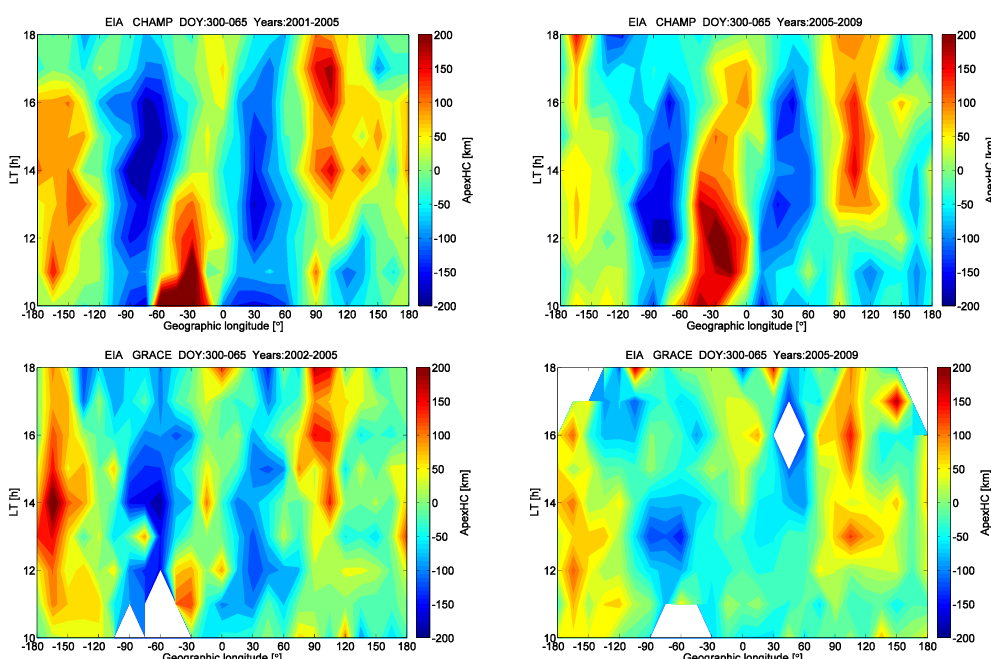
Fig. 2. Same as Fig. 1, but for the EIA parameter ApexHC. 616